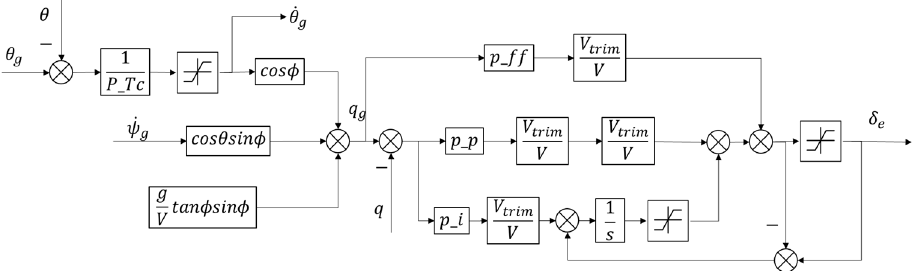
Figure B1. Pitch angle control structure. Figure A1. Pitch angle control